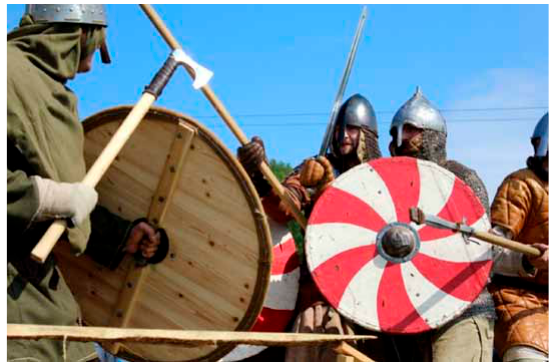
Fig 2. Fighting episode from “On Stones Trees Also Grow”